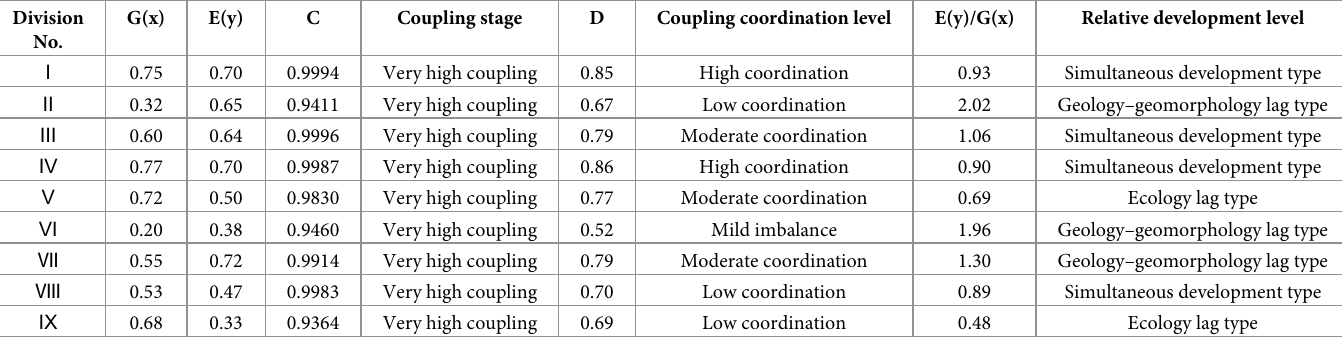
Table 4. CCD evaluation results of different eco–geological divisions in Northeast China. Division